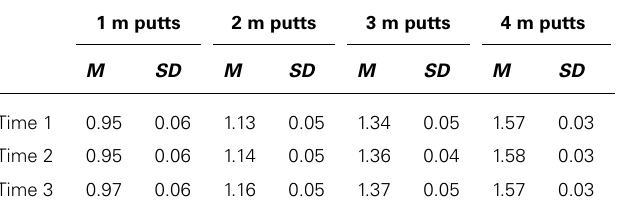
Table 3 | Means and standard deviations for the velocity of putterhead (ms -1 ) at the point of impact for each of the four putt distances